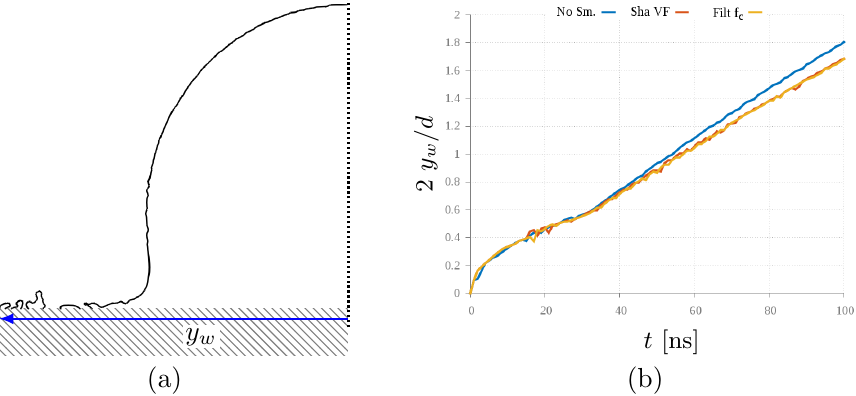
Figure 7. Contour level of α = 0.5, with velocity field arrows coloured by This influence can be quantified looking at the spreading of the liquid at the wall, Figure 8. Reducing the spurious currents, the liquid ejected spreads slower, while no variation is observed with the introduction of the filtering.